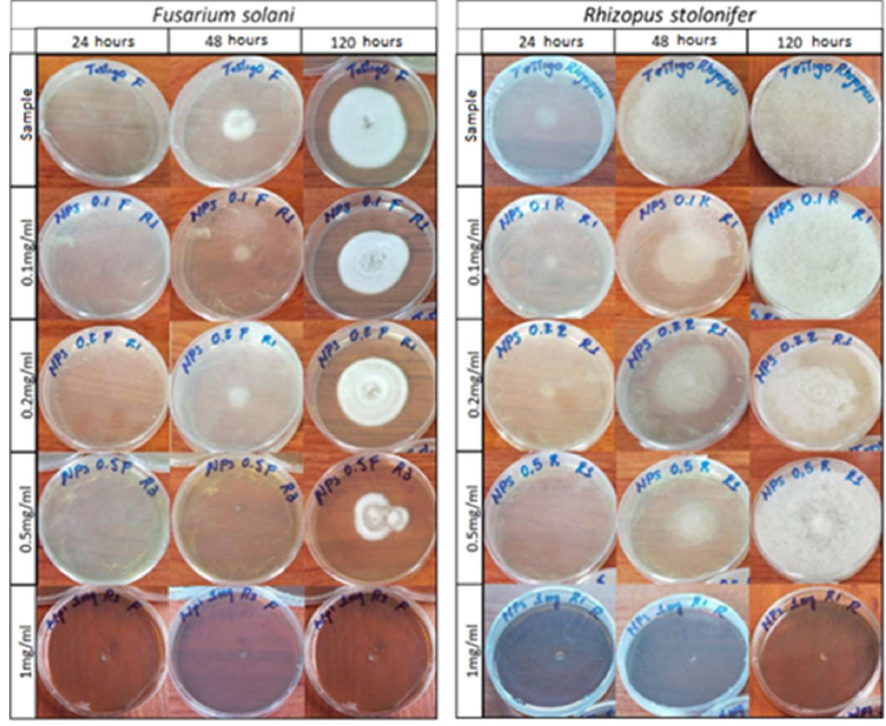
Figure 11. Photographic record of the growth of the fungi Fusarium solani and Rhizopus stolonifer.